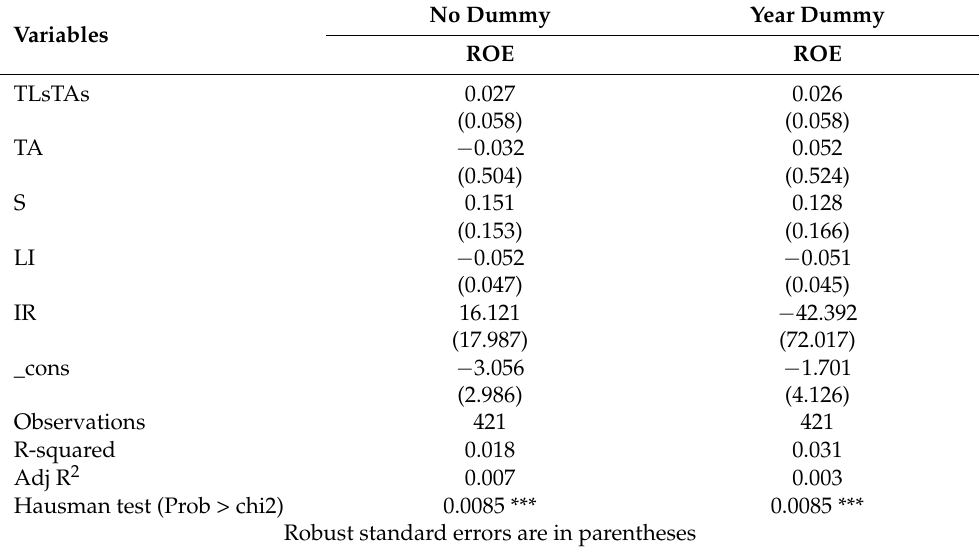
Table 11. Results of the Fixed Effects of TLsTAs on ROE, as per Panel Data Regression.